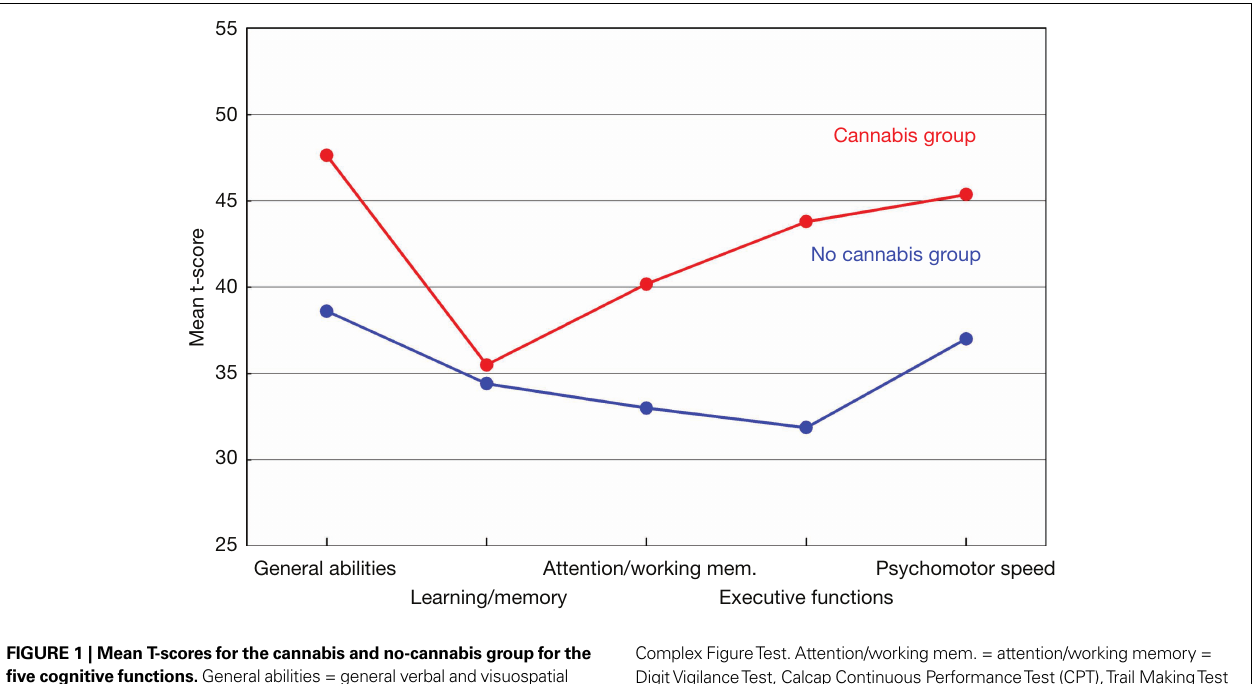
Complex Figure Test. Attention/working mem. = attention/working memory = Digit Vigilance Test, Calcap Continuous Performance Test (CPT), Trail Making Test B. Execute functions = Wisconsin Card Sorting Test (WCST), Stroop Test. Psychomotor speed = Trail Making Test A, Grooved Pegboard Test, Fingertapping